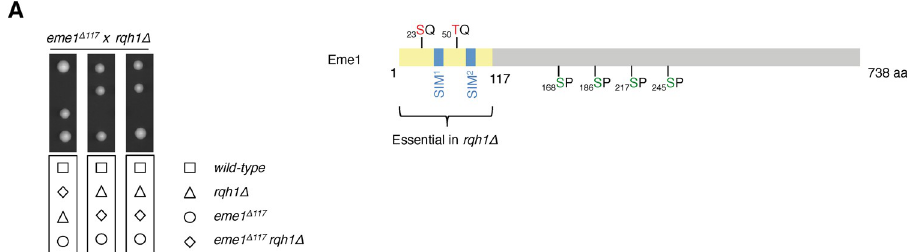
Fig 1. Eme1 N-terminal part (1–117) is essential in absence of Rqh1 BLM . A- Tetrad analysis of an eme1 Δ 117 x rqh1 Δ mating, germinated at 30˚C. Boxes below dissections indicate the genotypes of each spore. B- Schematic of Eme1 protein. The yellow box depicts the first 117 amino-acid residues required for cell survival in absence of Rqh1 BLM . The serine and threonine residues responding to Rad3 ATR -consensus phosphorylation sites are depicted in red and the SUMO-Interacting Motifs are represented by blue squares. The serine residues targeted by Cdc2 CDK1 are depicted in green.